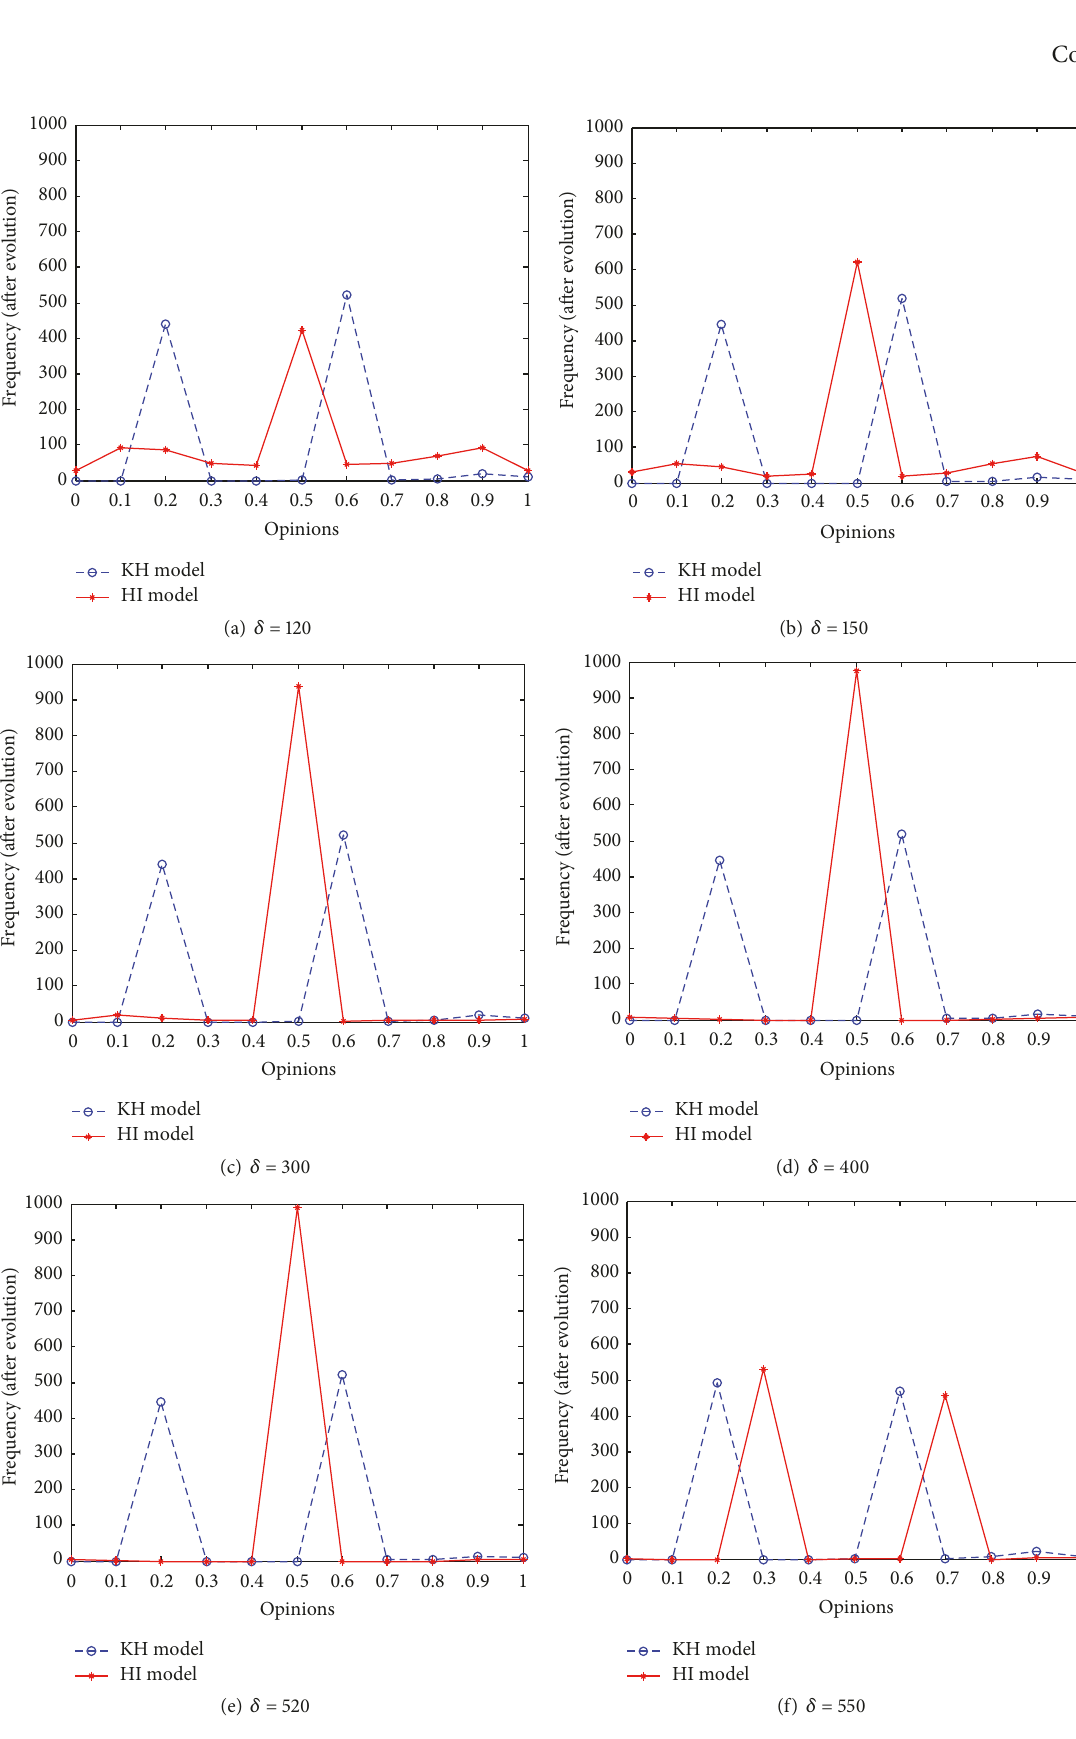
Figure 8: The final opinion distribution of HI model and KH model in scale-free network, 𝜀 = 0.2. (a) 𝛿 = 120, (b) 𝛿 = 150, (c) 𝛿 = 300, (d) 𝛿 = 400, (e) 𝛿 = 520, and (f) 𝛿 =